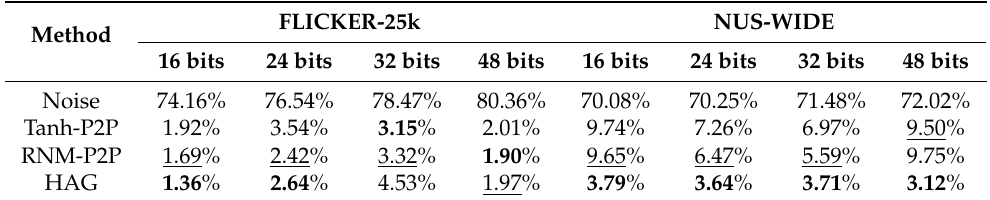
Table 3. MAP (%) of non-targeted attack with various attack methods for queries on the FLICKER-25K and NUS-WIDE datasets with 16, 24, 32, and 48 bits hash code. The best results are marked in bold, and the second best results are underlined.